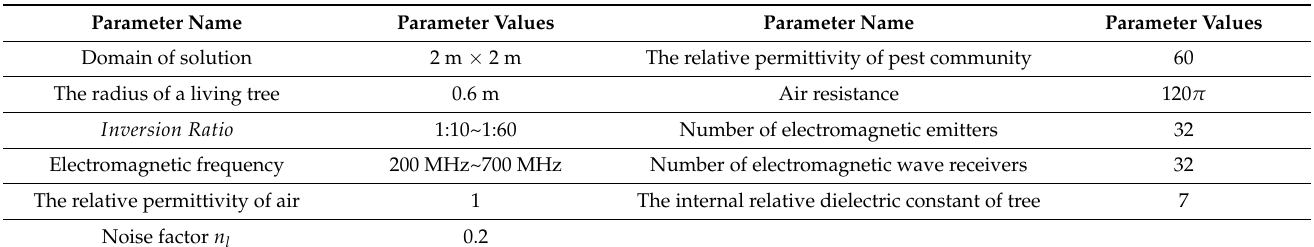
Table 2. Simulation parameter